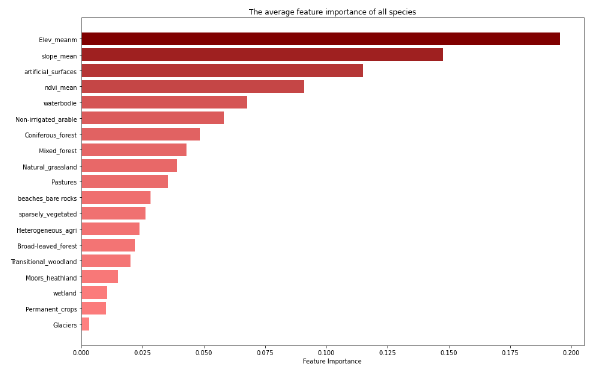
Figure 6. Average environmental variable importance derived from Balanced-RF for all species